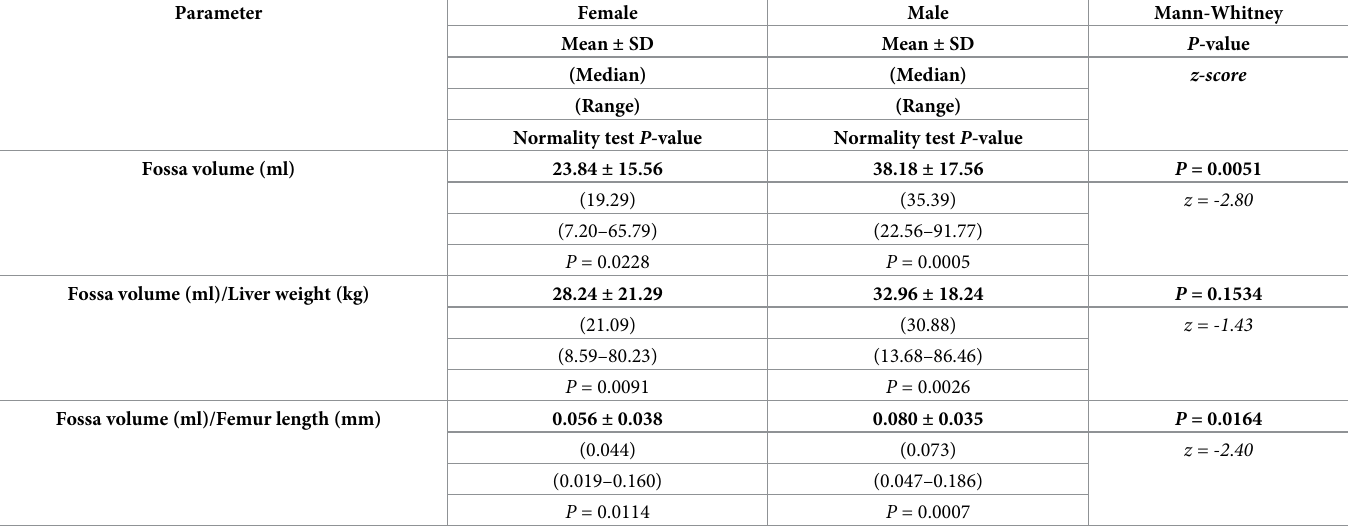
Table 3. Gallbladder fossa parameters in livers with gallbladders, segregated by